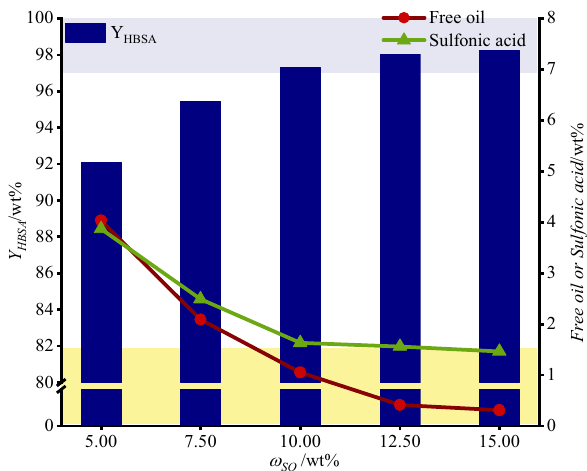
Figure 7: E ff ect of SO 3 mass fraction on the yield of HBSA, free oil and free sulfonic acid, featuring a reaction temperature of 50°C, SO 3 :HDB molar ratio of 1.10:1 and residence time of 10.18 s. The pale navy blue parts indicate the range of HBSA content in the superior products, and the pale yellow parts represent the ranges of free oil and sulfonic acid content of the superior